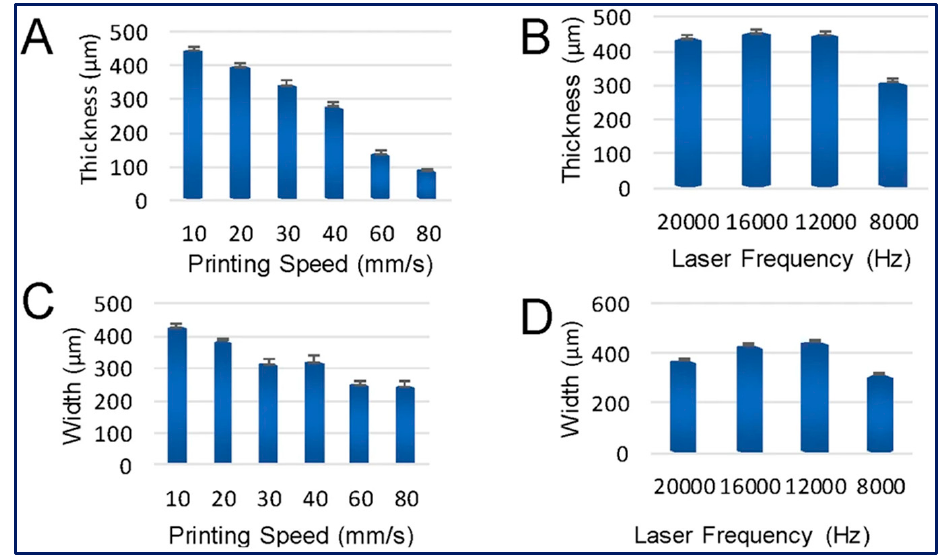
Figure 2. The effects of printing speed and laser frequency on printed scaffolds. ( A ) The effect of various printing speeds on thickness of struts at a laser frequency of 12,000 Hz. ( B ) The effect of various laser frequencies on thickness of struts at a printing speed of 10 mm/s. ( C ) The effect of various printing speeds on width of struts at a laser frequency of 12,000 Hz. ( D ) The effect of various laser frequencies on width of struts at a printing speed of 10 mm/s. Reprinted with permission from [70].